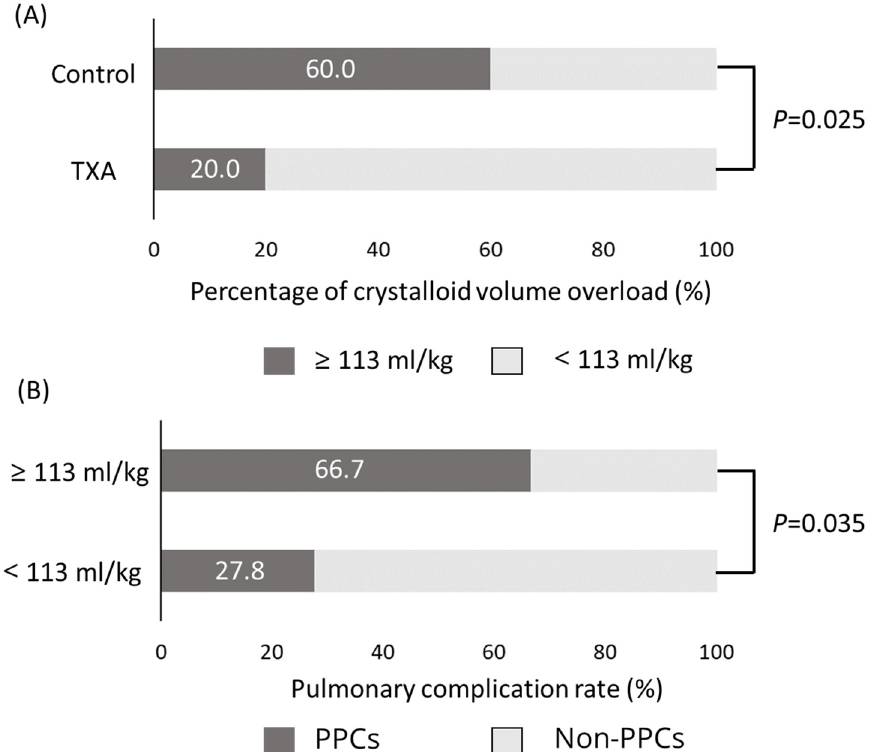
Figure 2. Proportion of patients with crystalloid volume overload ( ≥ 113 mL/kg) in the control and tranexamic acid (TXA) groups ( A ). Proportion of patients with pulmonary complications (PPCs) in the crystalloid volume overload ( ≥ 113 mL/kg) and non-overload (<113 mL/kg) groups ( B ).